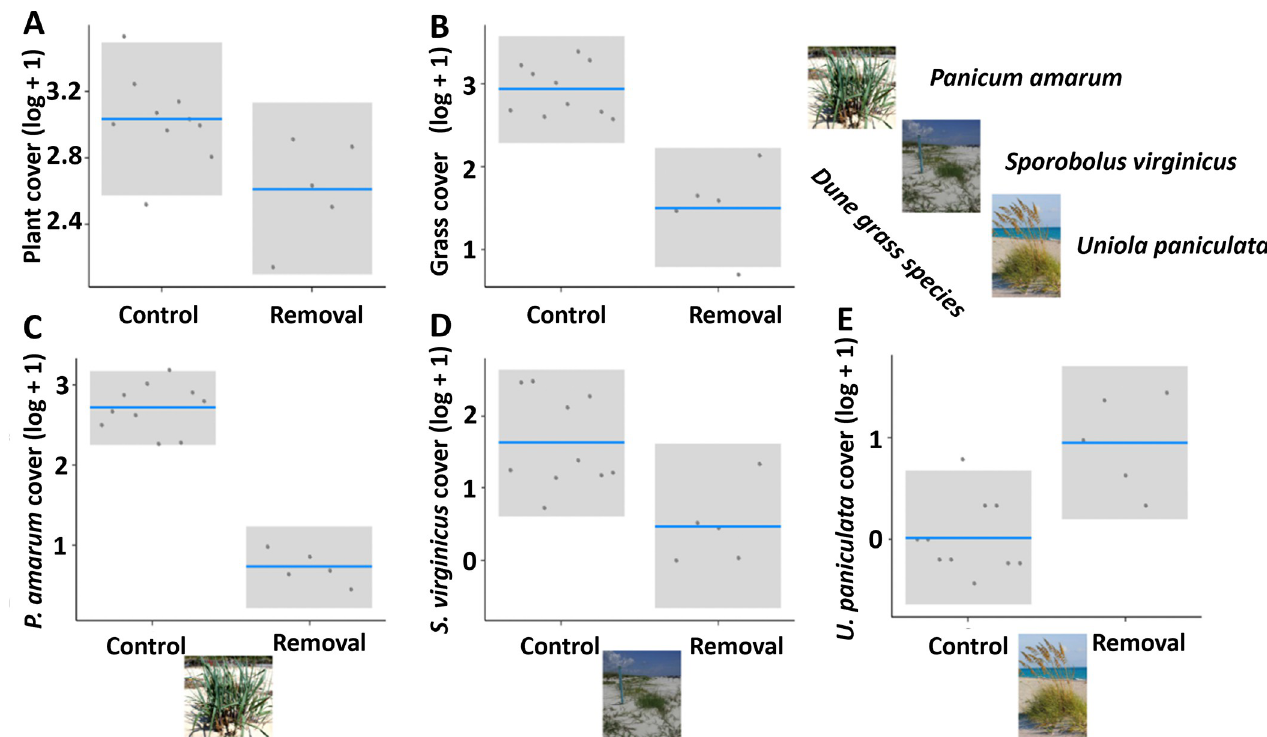
Fig 3. Effects of wrack removal on plant variables. All plots show the partial residuals from linear models accounting for experimental block as a function of treatment type. The variables shown are: log-transformed cover of all plants (A) , all grasses (B) , P . amarum (C) , S . virginicus (D) , and U . paniculata (E) I . Plant variables were taken after 16 months. Grey area are the 95% confidence